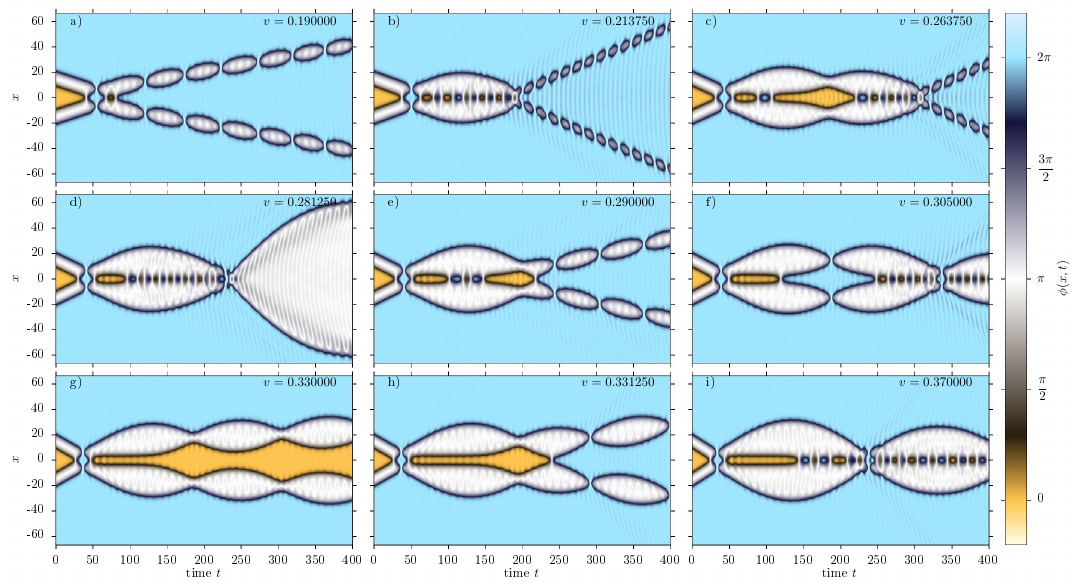
Figure 27 . Example scattering processes for a variety of initial velocities at (cid:15) = 2 . 59935 ( β = 3 . 09887 ), illustrating the variety of behaviours of the subkinks after the initial four-way collision. lide with the bion at the centre. The time scale for this recollision is large, comparable with the period of the lowest oscillations of the double kink, which is of order e β (see section 2.4). The collision between the returning outer subkinks and the bion is a chaotic process